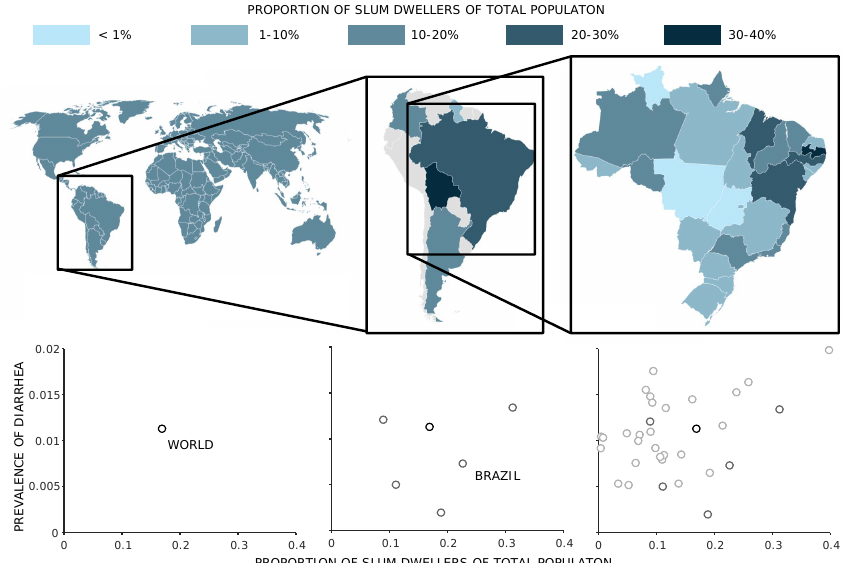
Figure 8. Graphical visualization of the proportion of slum dwellers of the total population for the world ( left ), different South American states ( middle ), and the 26 districts of Brazil ( right ). For the grey shaded countries in South America, no information on the slum population is available. The scatter plots in the lower row show the prevalence of diarrheal diseases in the respective areas (World, South America, Brazil) on the Y-axis above the proportion of slum dwellers of the total population on the